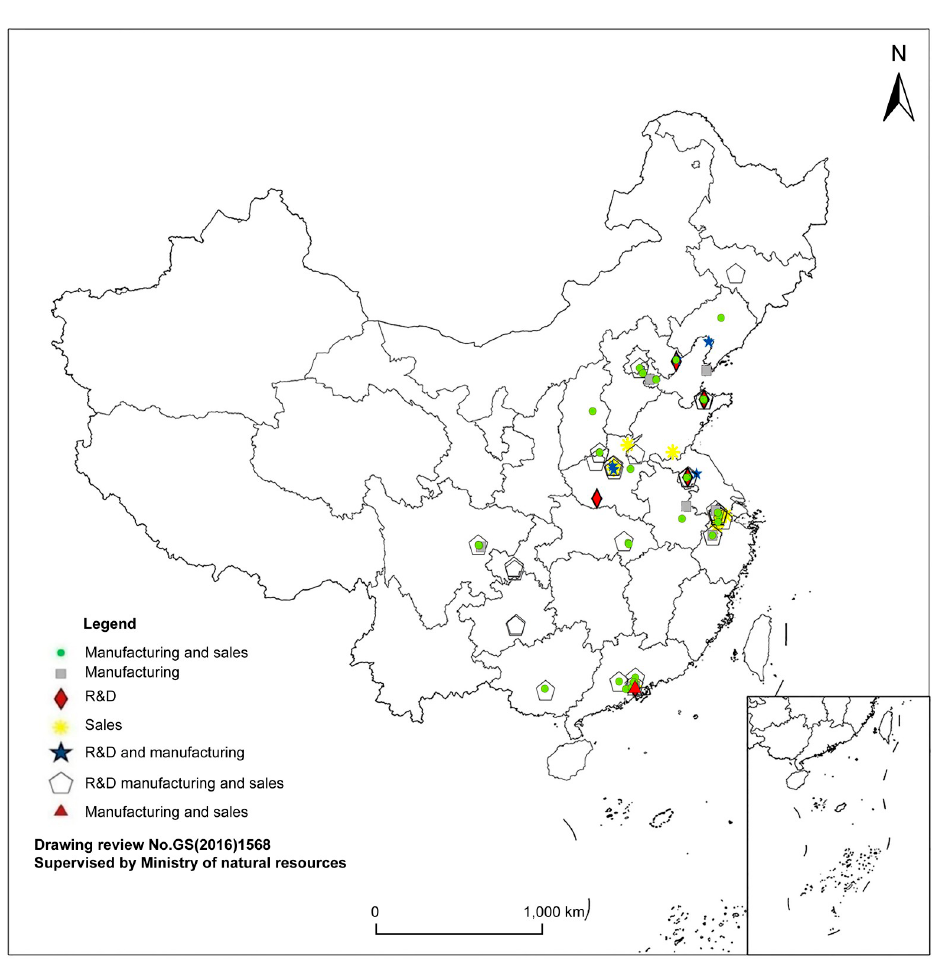
Fig 8. Spatial positioning map for the value chain models of enterprises